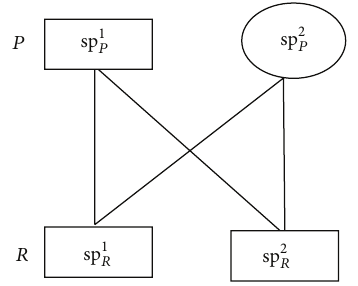
Figure 2: Security strategy